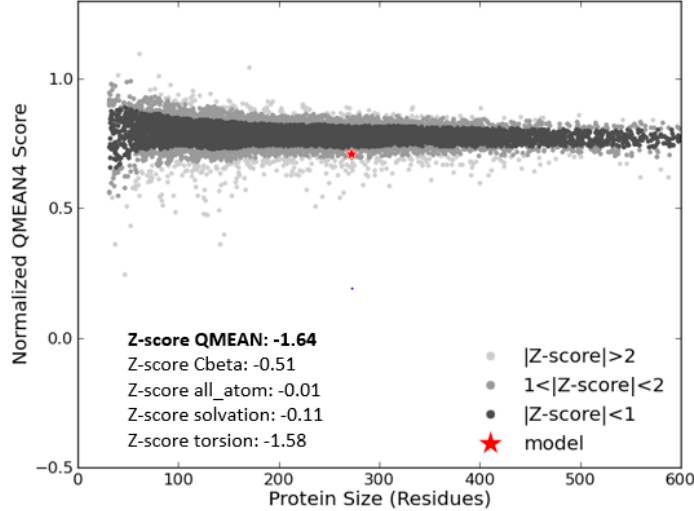
Figure 4. Structural quality of the modelled MIC-A protein. The Z-score of MIC-A protein is compared with non-redundant sets of PDB structures showing the quality of the modelled structure by the Swiss model.